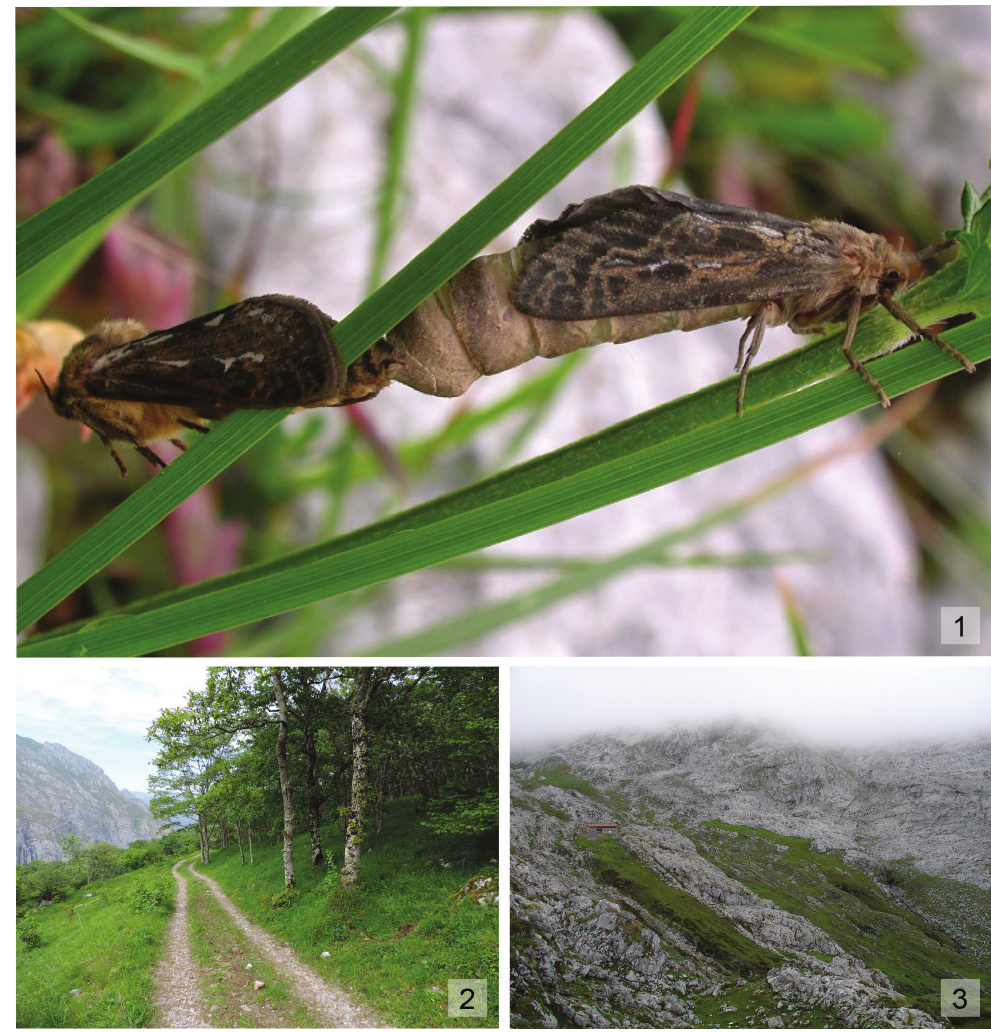
Figures 1–3. 1. P. cantabricus sp. n., mating pair, Spain, Cantabria, Picos de Europa, Sierra Bejes. 2. Type locality of P. cantabricus sp. n. at the Sierra Bejes at about 800 m altitude. 3. Habitat of P. cantabricus sp. n. above the Lagos de Covadonga, at about 1375 m altitude. Image 3 , F. González. 32); 2 ♀, N Spain, Asturias, Picos de Europa National Park, Lagos de Covadonga, ca 1375 m, 43°14’37.10”N, 4°59’44.23”W, 20. July 2007, during the day, leg. F. J. G. Estébanez (CFG, genitalia prep. AK861, Figs 8,